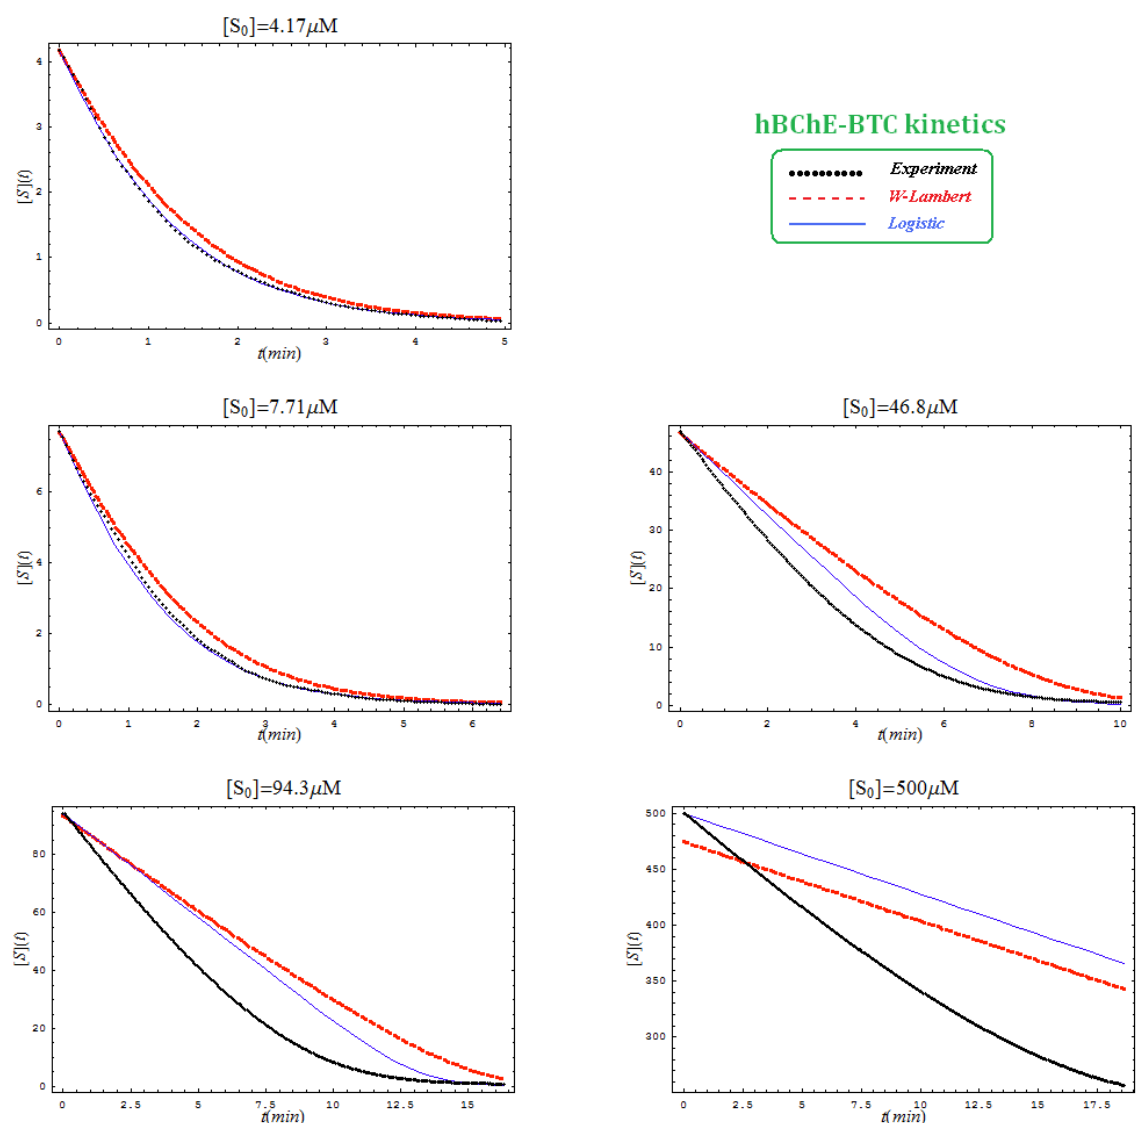
Figure 5. The same type of plots as in Figure 3, here for hBChE-BTC kinetics and parameters K = 7.5 µM; K =8,700 µM; V = 7.2 µM/min; b = S SS max